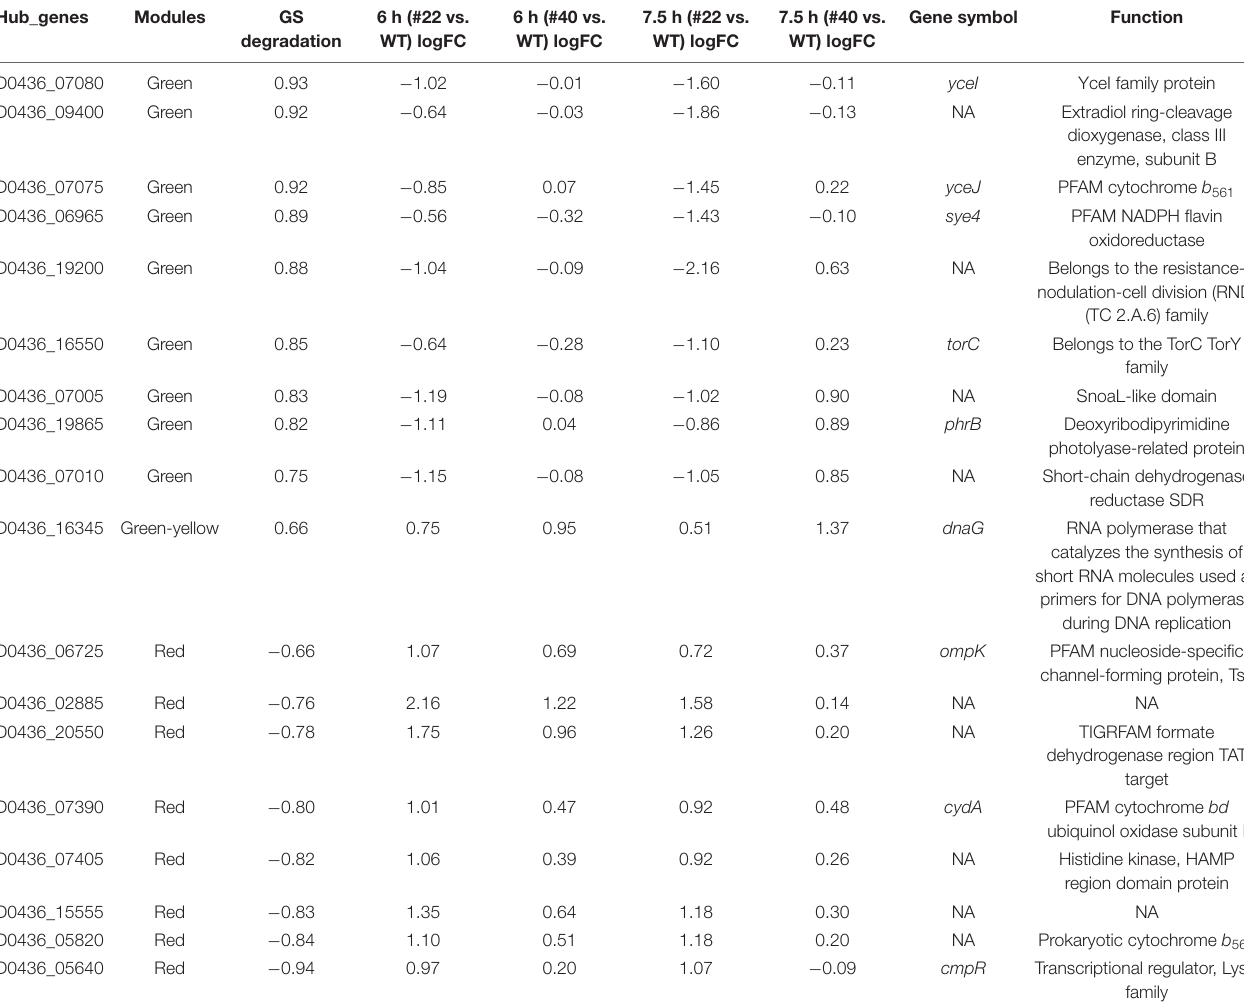
TABLE 1 | Characterization of the differentially expressed hub